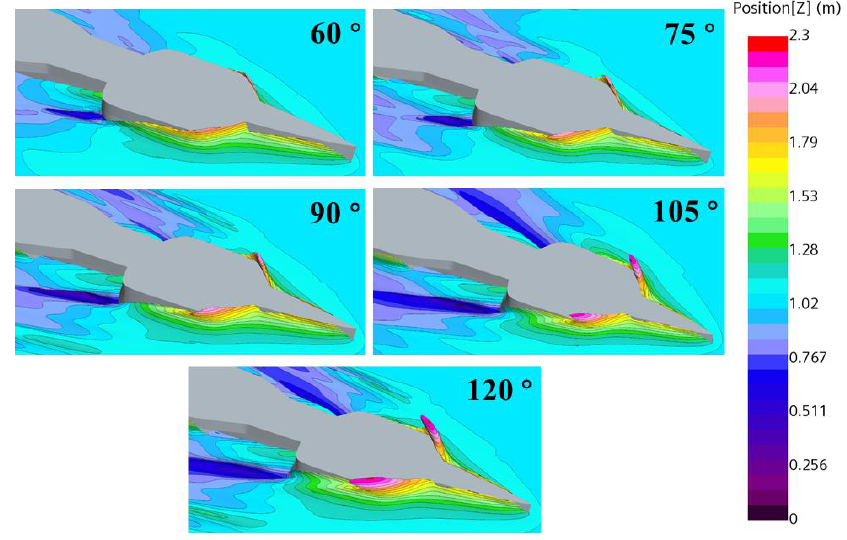
Figure 9. Hydrostatic free-surface emerging waves for five outrigger inclination configurations at Fr = 0.5.